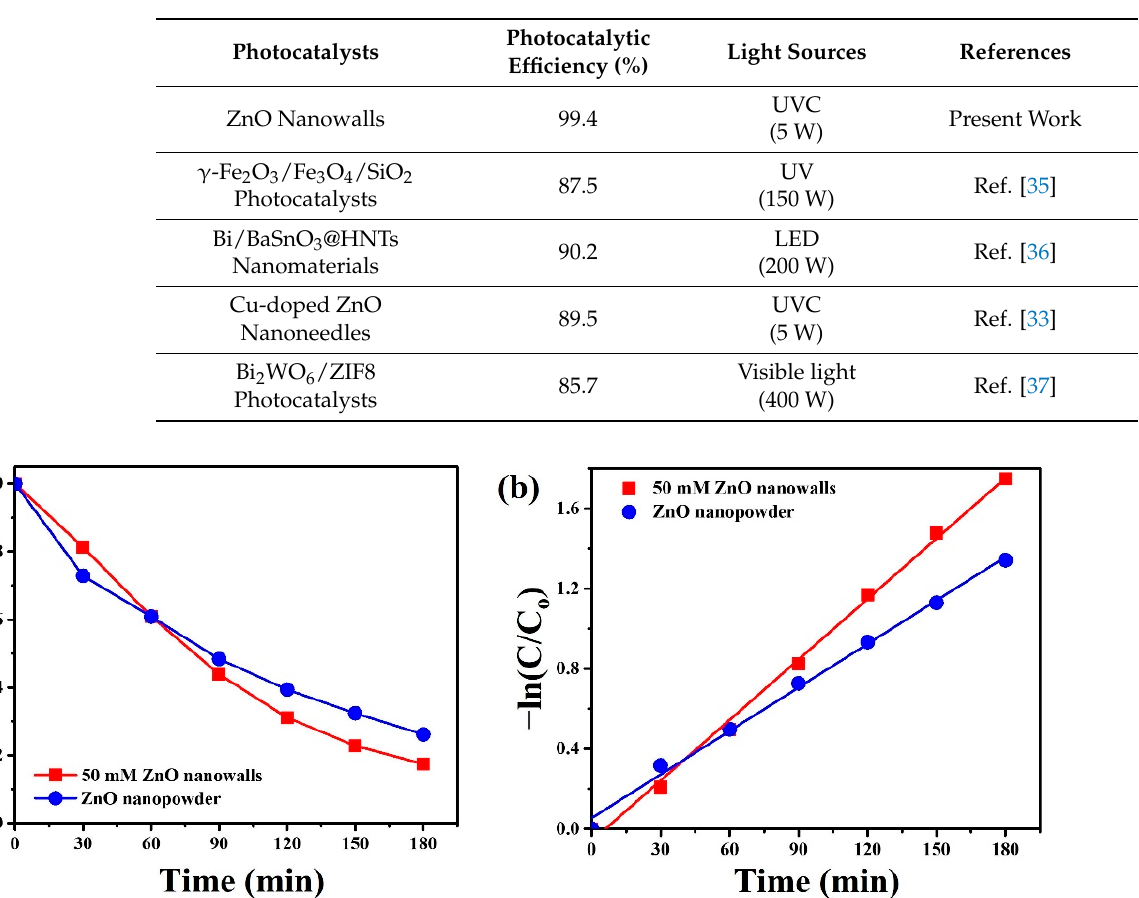
Figure 9. ( a ) Photocatalytic activities and ( b ) kinetic linear simulation curves of ZnO nanowalls (50 mM) and commercial ZnO nanopowder for TC solution under UVC light irradiation.